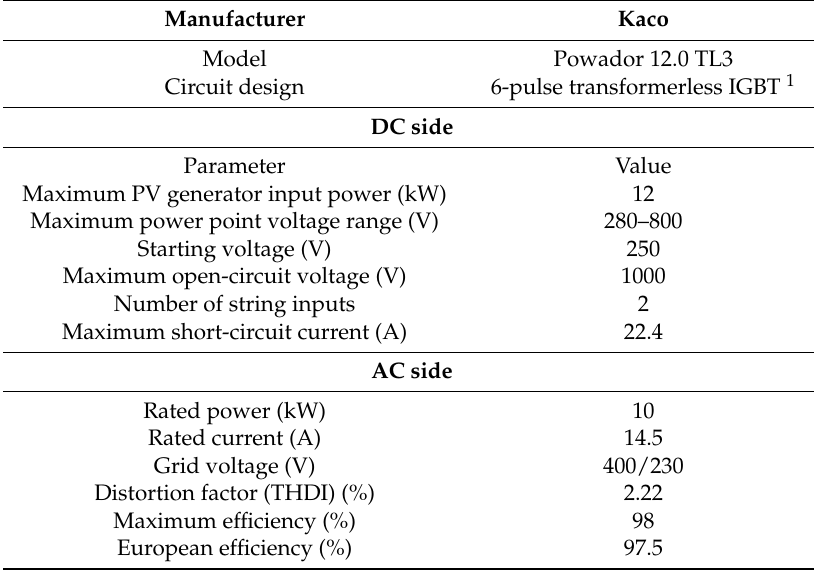
Table 1. Technical characteristics of the photovoltaic (PV) plant inverter